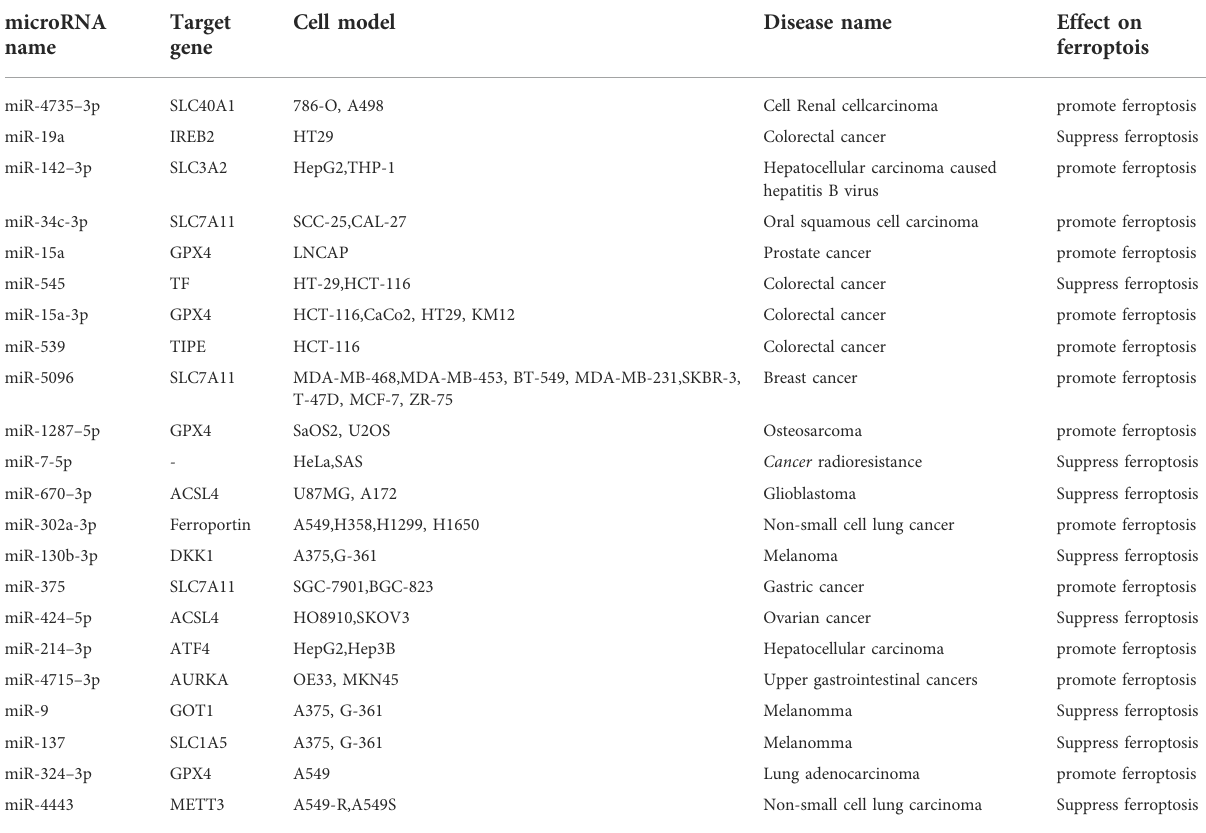
TABLE 2 The role of microRNA in tumor via regulating ferroptosis.